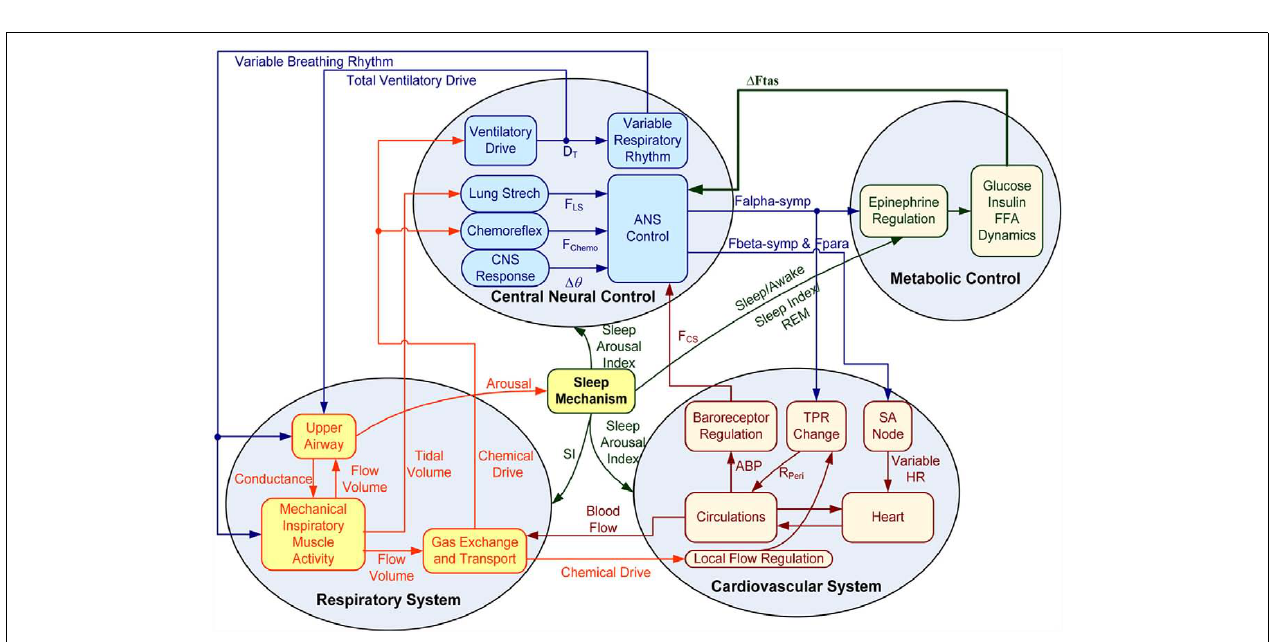
FIGURE 2 | Diagram of integrative model of autonomic and metabolic